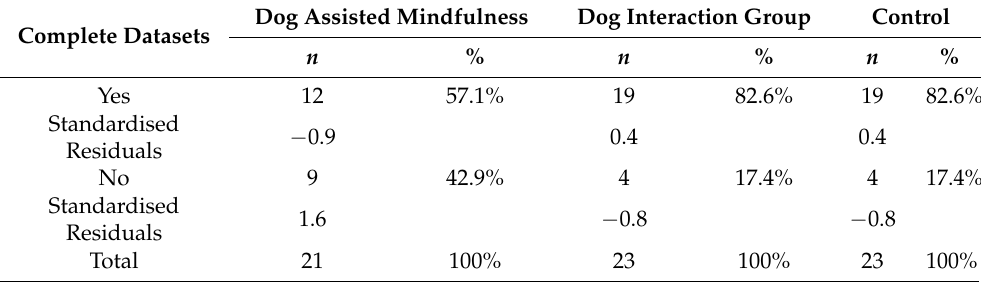
Table 3. Complete datasets group